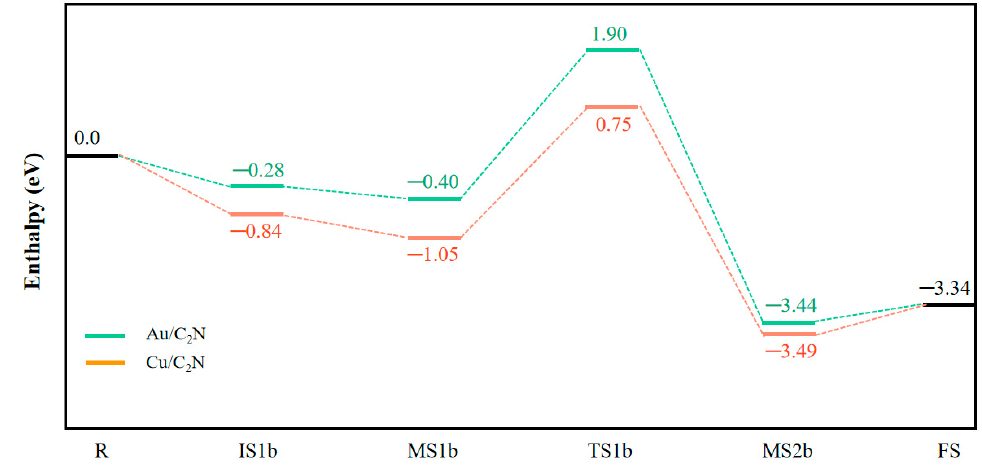
Figure 9. Energy profiles along the MEP for the N 2 O reduction via mechanism II. (R: M/C 2 N + N 2 O + CO, FS: M/C 2 N + N 2 + CO 2 .)